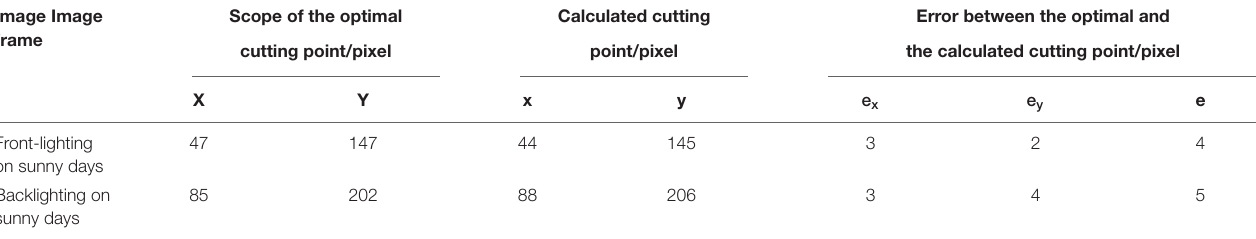
TABLE 3–1 | Comparison table of cutting point and pixel positioning error under two types of